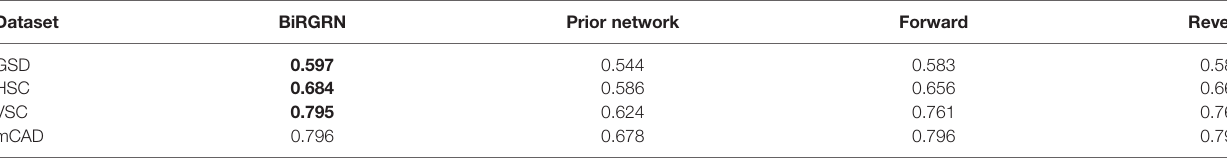
TABLE 4 | The AUROC value of the algorithm and three variants on the simulated datasets.